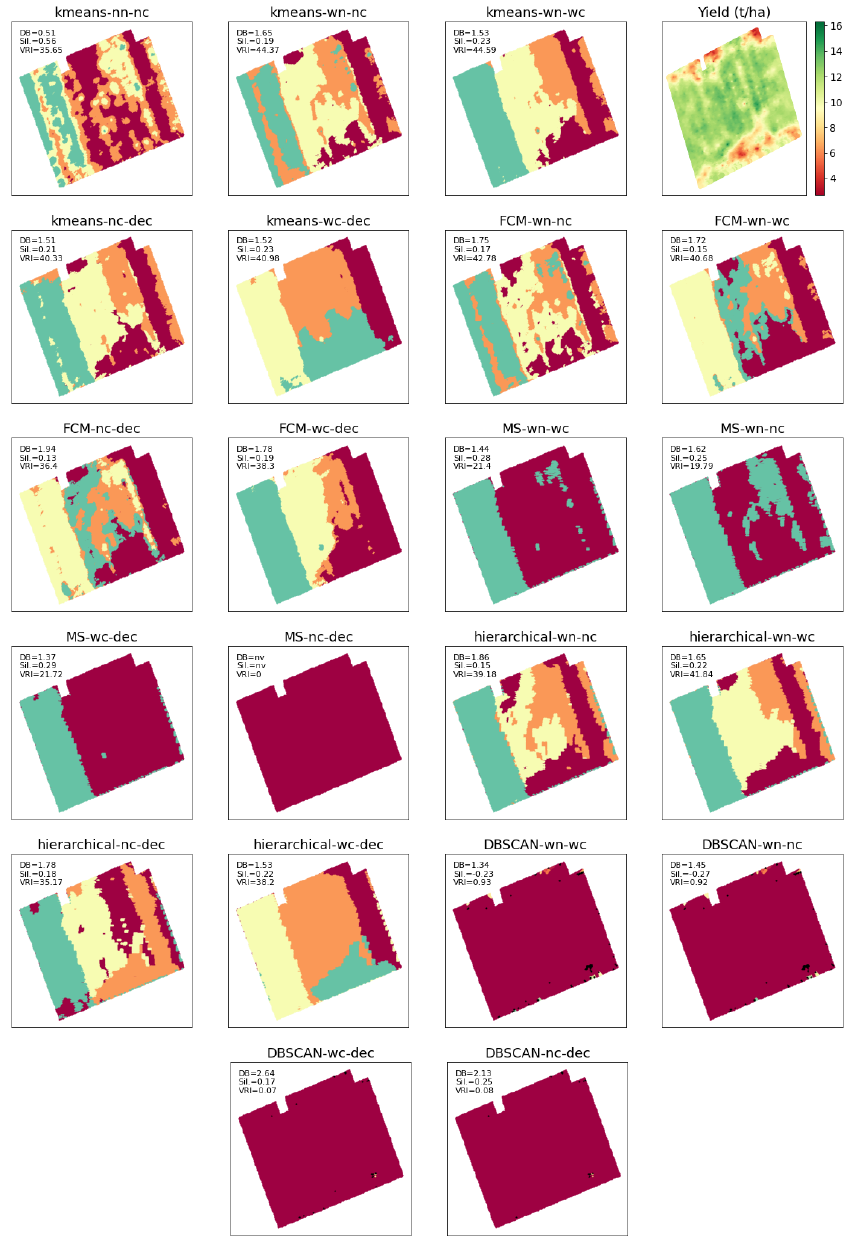
Figure 5. Comparison of different clustering schemes in delineation of management zones, shown for field Krokey as an example. When not explicitly mentioned in the scheme title, normalization is included. The clustering performances are evaluated in terms of Davies–Bouldin score (DB), Silhouette score (Sil.), and variance reduction index